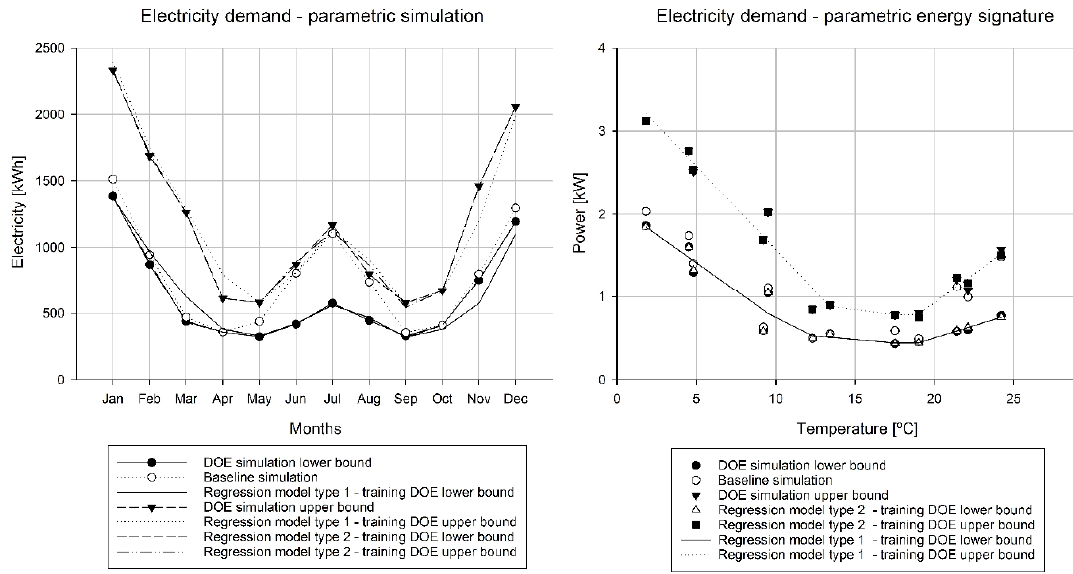
Figure 3. Electricity demand—DOE parametric model simulation and training (a priori knowledge) for monitoring purpose.